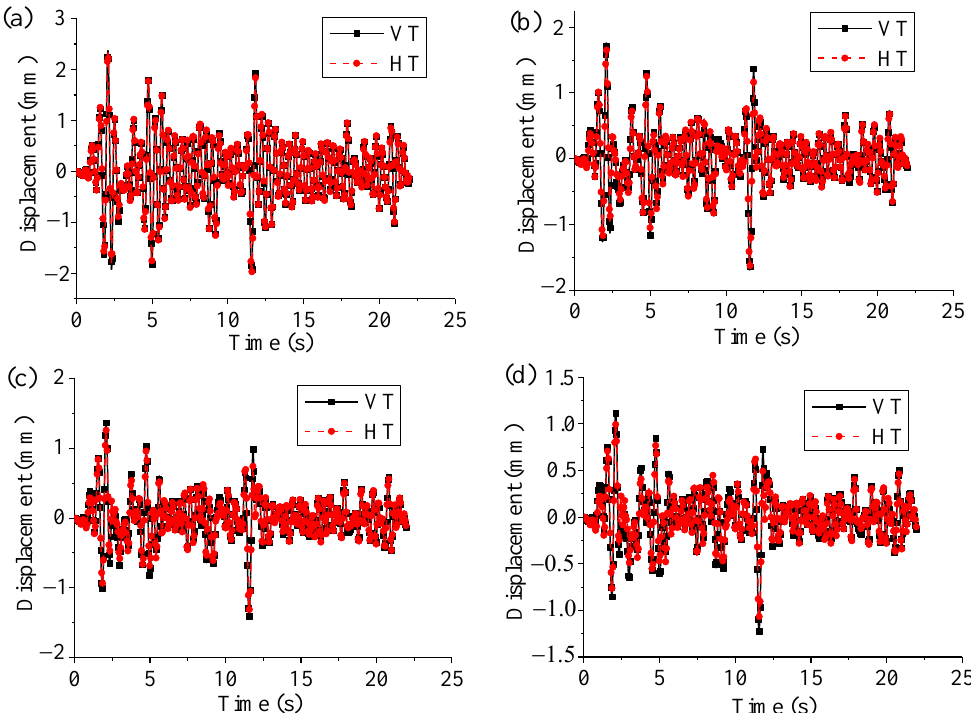
Figure 6. The time-domain displacements of different models due to El Centro wave: ( a ) Model A; ( b ) Model B; ( c ) Model C; ( d ) Model D.